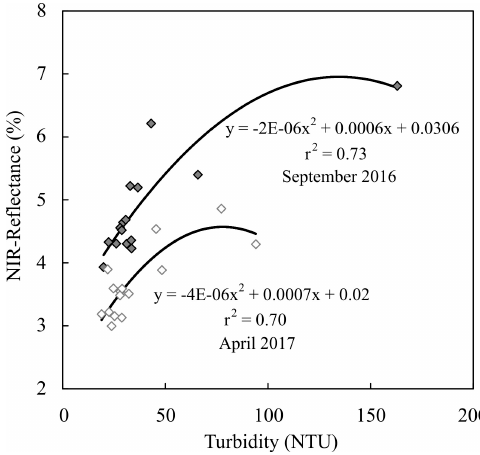
Figure 10. Functions of correlation between the NIR-reflectance and turbidity.